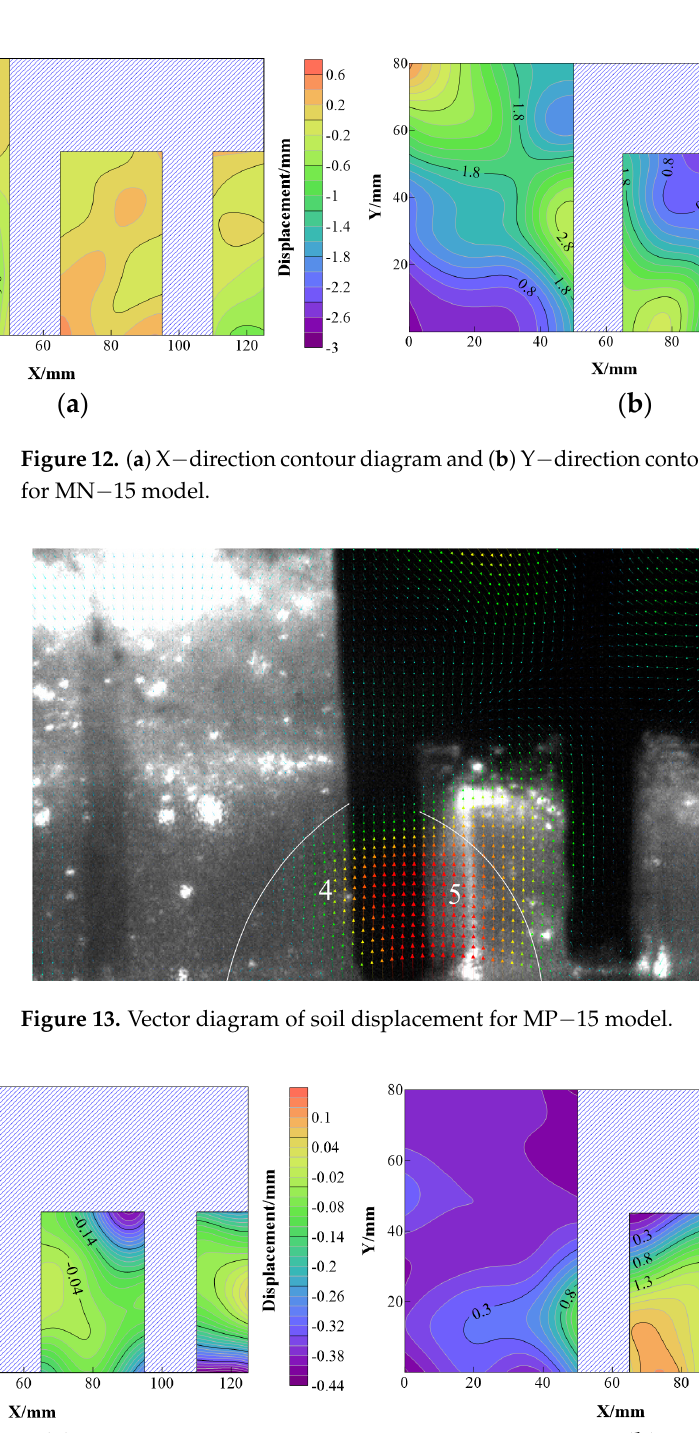
( d ) Figure 15. Vector diagram of ( a ) SN − 15 model, ( b ) SP − 15 model, ( c ) LN − 15 model, and ( d ) LP − 15 model. 3.2. Load-Displacement Curve Figure 16 presents the load-displacement curve of the gridded hard crust structure. Considering that the destruction mode of the gridded hard crust structure under the limit state was investigated in this study, the ultimate load of the structure, namely, the peak load, was emphasized in the load-displacement diagram. The relationship between the ultimate load and cement content and model construction is demonstrated in Figure 17. As observed in the figure, the cement content exerted a great influence on the law of de- struction load change. Under the same thickness of hard crust, the ultimate load increased with the increase in s when the cement content was low. At t/h = 0.5, the ultimate loads of MN-8 and LN-8 increased by 24.1% and 55.7% compared to SN-8, and at t/h = 1, the ulti- mate loads of MP-8 and LP-8 increased by 12.5% and 61.8% compared to SP-8, respec- tively. However, the opposite situation appeared when the cement content was high. At t/h = 0.5, MN-15 and LN-15 each lost 27.9% and 53.3% of their ultimate load compared to SN-8; at t/h = 1; MP-15 and LP-15 each lost 21.7% and 30.5% of their ultimate load com- pared to SP-15.